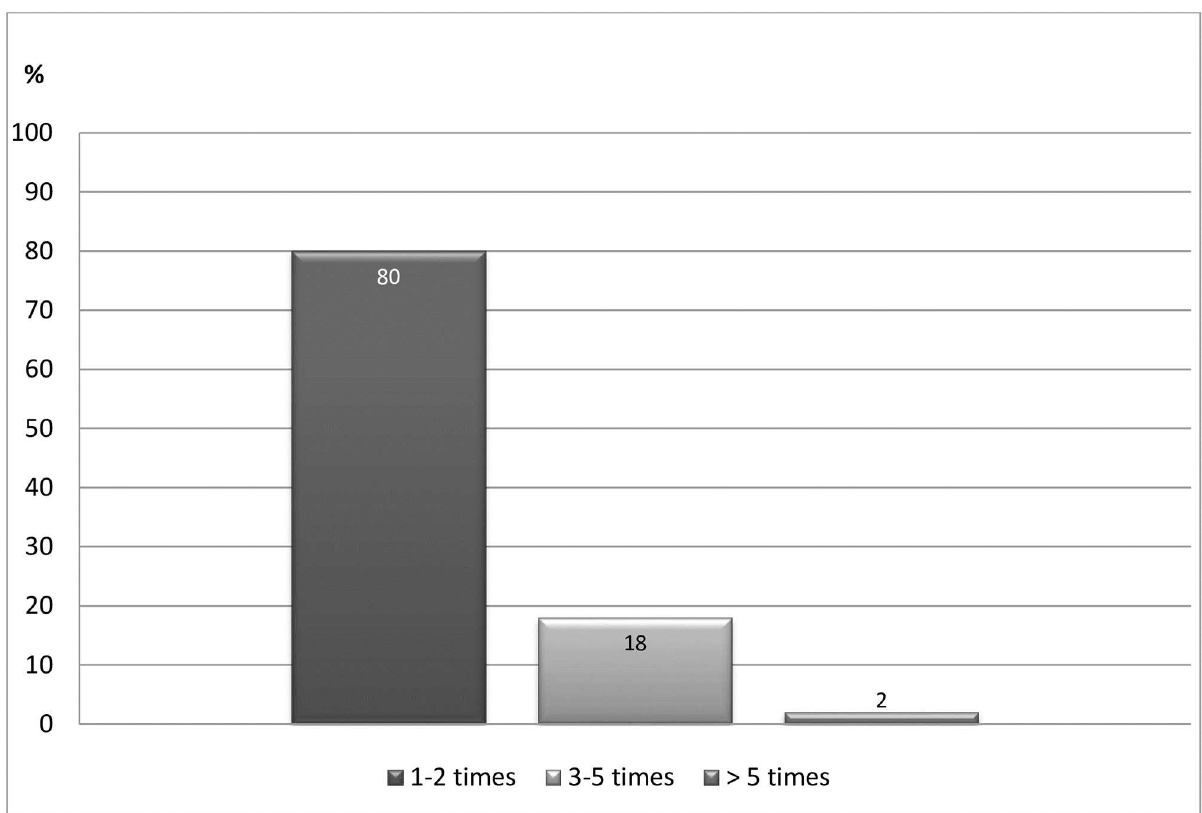
Fig 2. The relative distribution of support from the PAP-responsible nurse at the health care centre. Was measured at the 6 months follow-upwith a question,to the patient, about contact frequency.